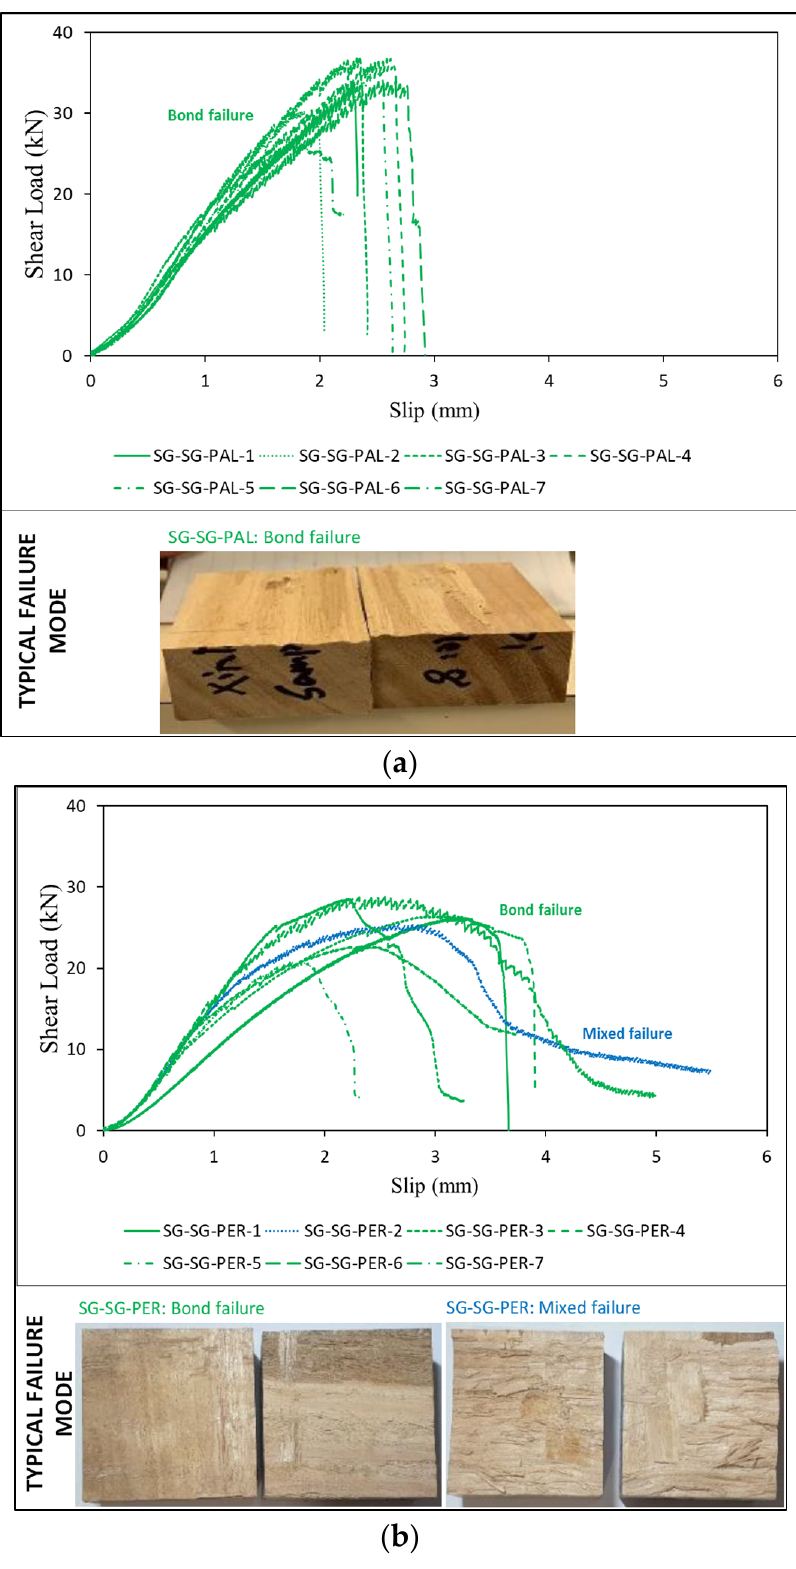
Figure 5. Loading curves and typical modes for SG–SG samples. ( a ) SG–SG–PAL, ( b ) SG–SG–PER.